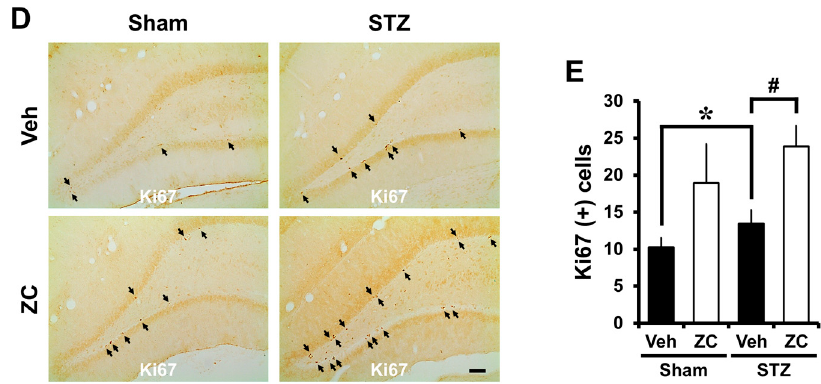
Figure 1. ZC increases proliferation of progenitor cells in the early phase of STZ-induced diabetic rats. ( A ) Experimental procedure in the early phase of STZ-induced diabetic rats. IP: intraperitoneal, PO: per os; ( B ) Bright field photomicrographs show BrdU (+) progenitor cells in the hippocampal dentate gyrus (DG). In the early phase, STZ-injected group showed a significant increase of BrdU (+) cells. ZC treatment by gavage for one week after STZ-induced hyperglycemia further increased BrdU (+) cells. Scale bar = 100 µm; ( C ) Bar graph represents the number of BrdU-positive cells in the subgranular zone (SGZ) of DG. Data are means ± SE, n = 7–12 from each group. * p < 0.05, versus vehicle-treated sham group; # p < 0.05, versus vehicle-treated STZ group; ( D ) Representative photomicrographs show Ki67 (+) cells in the hippocampal DG. The Ki67 (+) cells is indicated by a black arrow. In the early phase, the STZ-injected group showed a significant increase of Ki67 (+) cells. Short-term ZC treatment increased the number of Ki67 positive cells in STZ-induced diabetic rats. Scale bar = 100 µm; ( E ) Bar graph represents the number of Ki67 (+) cells in the SGZ of DG. Data are means ± SE, n = 7–12 from each group. * p < 0.05, versus vehicle-treated sham group; # p < 0.05, versus vehicle-treated STZ group.